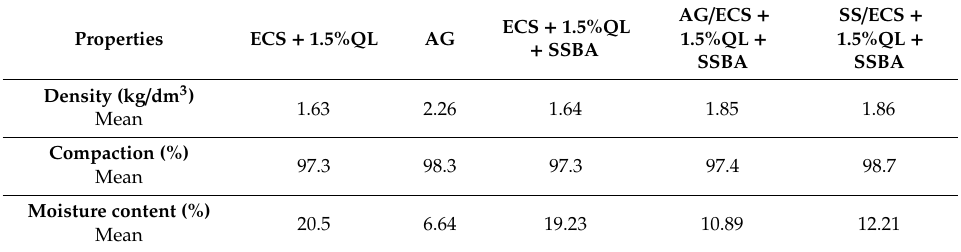
Table 5. In situ assessments of density and